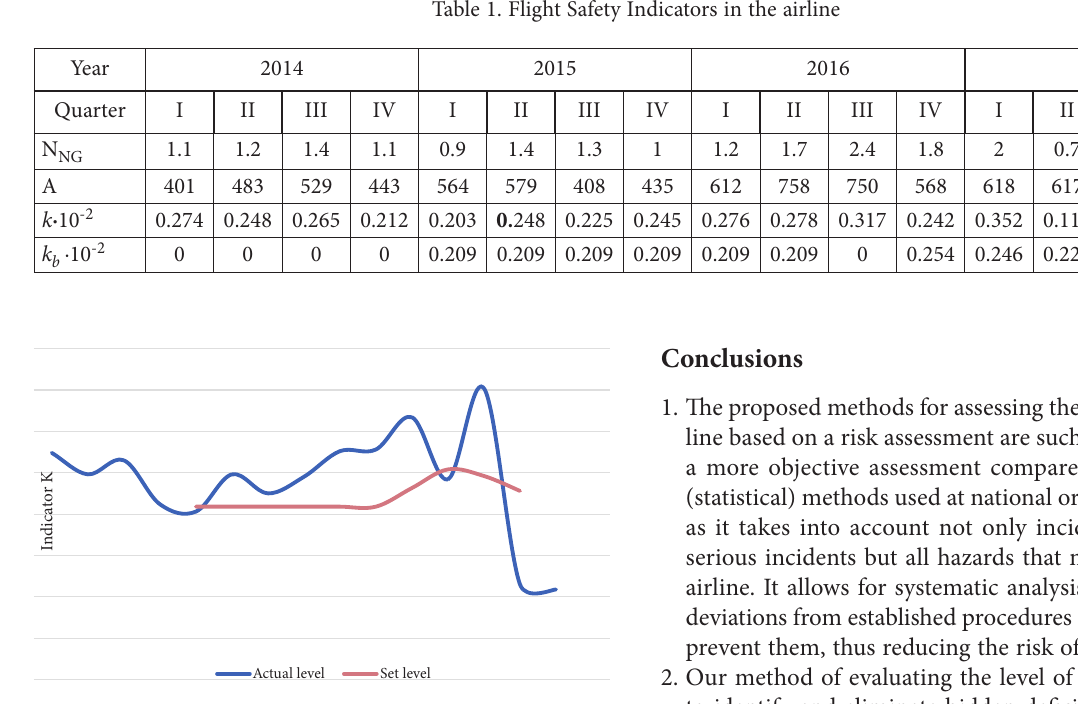
Figure 2. The change in the flight safety indicator of the airline by